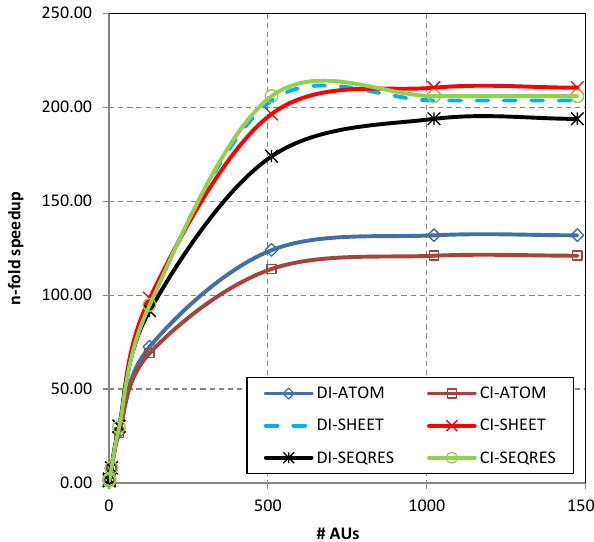
Figure 5. n-fold speedups achieved when extracting data from various sections (ATOM, SHEET, SEQRES) of compressed (CI) and decompressed (DI) individually stored PDB files for the varying number of allocation units